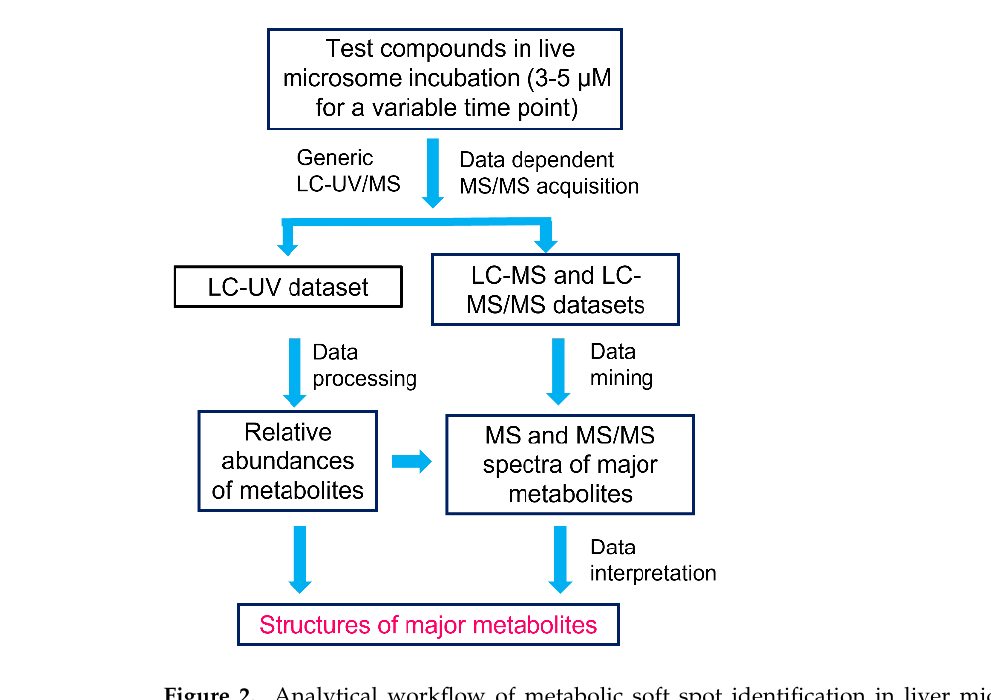
Figure 2. Analytical workflow of metabolic soft spot identification in liver microsomes using LC/UV/MS. Individual test compounds are incubated at 3 or 5 µM for a variable time based on predetermined metabolic stability data. LC/UV/Q-TOF and LC/UC/Qtrap and associated data acquisition and data-mining methods are used for quantitative and qualitative analysis of major metabolites.